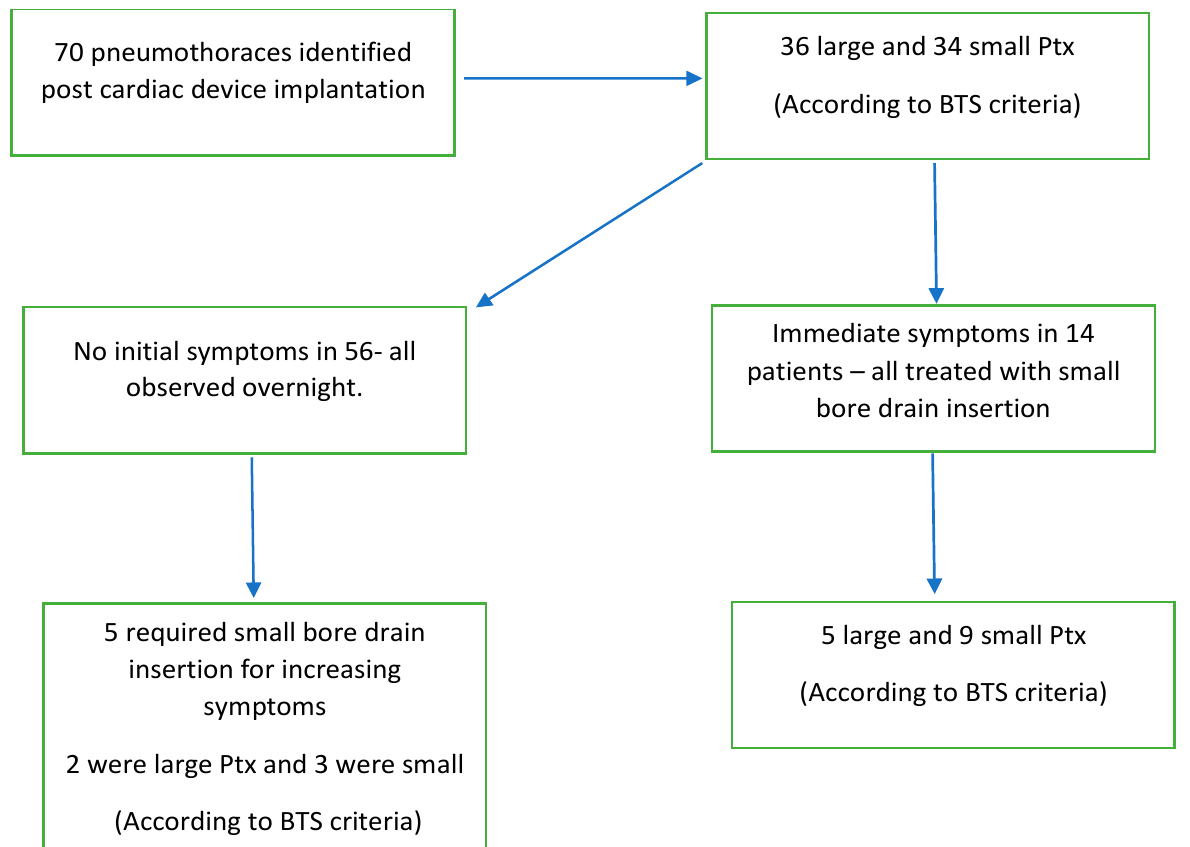
Figure 1. Treatment pathway of patients with pneumothoraxes (ptx) after cardiac-device implantation, according to size criteria .